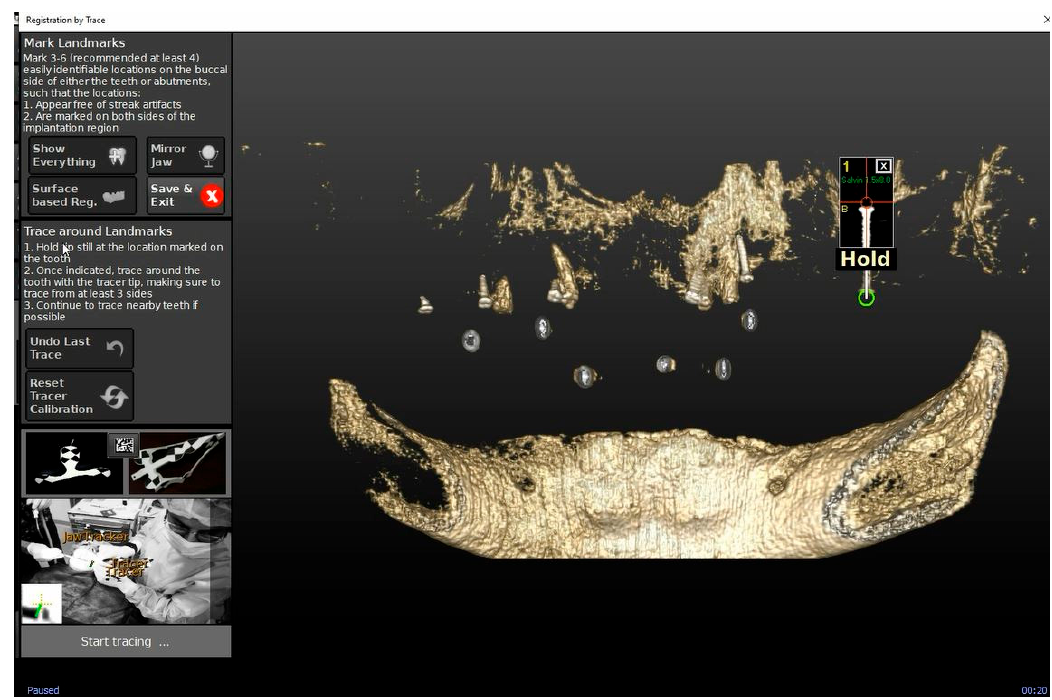
Figure 9. The automatic recognition of the mini screws by the software for the tracing phase. The complete trace and registration process took an average of 1–2 min. The accuracy of this phase is then assessed by touching with tracer’s ball tip any patient’s anatomical marker and confirming congruency between the touched marker and what was shown on the laptop screen (Figure 10).